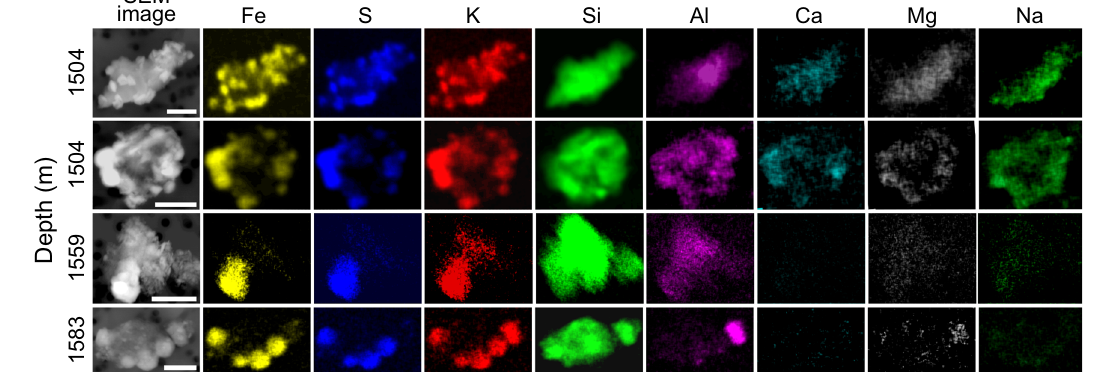
Fig. 3 Elemental maps obtained through SEM-EDX of dust grains from deep TALDICE ice. Scale bar: 2 µ m.